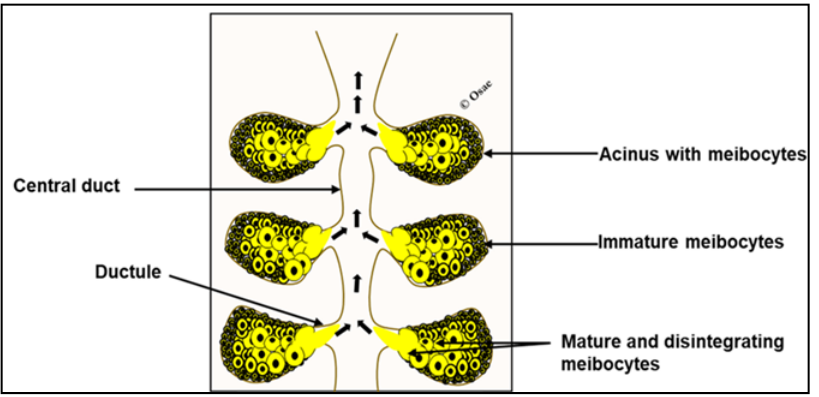
Figure 1. Schematic of the meibomian gland. Immature meibocytes reside at the periphery of acini and mature ones are central. Hyper-mature and lipid-laden meibocytes rapture and release meibum for upward delivery (short arrows) at the ocular surface.